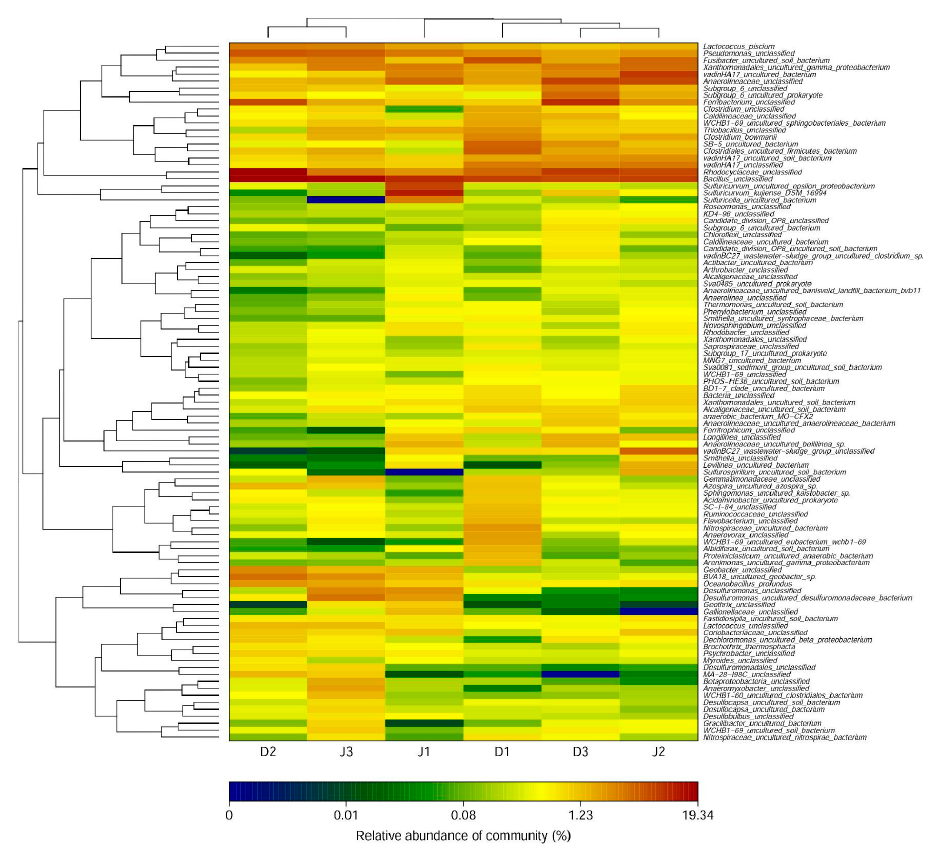
Figure 3. Bacterial genera of samples in the creeks (with relative abundances >0.01%). The heat map was plotted using the R program.